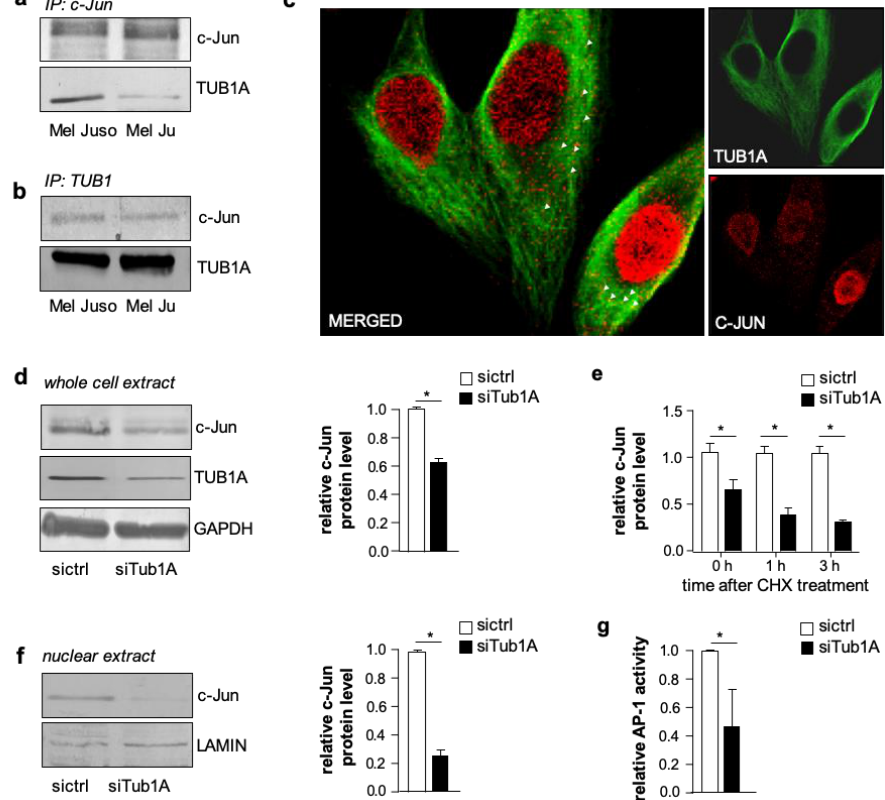
Figure 2. c-Jun protein interacts with TUB1A (Tubulin alpha chain) in melanoma cells and TUB1A a ff ects AP-1 activity and stabilizes c-Jun protein. ( a , b ) Immunoprecipitation (IP) analyses of melanoma cell (Mel Juso, Mel Ju) lysates revealed co-precipitation of TUB1A with an ( a ) anti-c-Jun antibody and vice versa, ( b ) c-Jun with anti-TUB1A antibody. ( c ) Immunofluorescence analyses showed co-localization (white arrows) of c-Jun (red) and TUB1A (green) in the cytoplasm of melanoma cells. ( d ) Western blot analyses and densitometry of c-Jun and TUB1A in whole cell lysates of Mel Juso cells after TUB1A si-RNA (siTub1A) or control si-RNA (sictrl) transfection. GAPDH (Glyceraldehyde-3-Phosphate Dehydrogenase) was used as a loading control. The bar graph depicts the quantification of protein amounts (mean ± s.d.) of three independent experiments. ( e ) Analyses of c-Jun protein expression in TUB1A-suppressed (siTub1A) and control (sictrl) Mel Juso cells after cycloheximide (CHX) treatment showed a faster decline of c-Jun levels in siTub1A compared to control cells. The bar graph (mean ± s.d. of three western blot analyses) depicts c-Jun levels normalized to GAPDH. ( f ) Western blot analyses and densitometry of nuclear extracts of Mel Juso cells showed lower c-Jun protein levels in TUB1A-suppressed (siTub1A) compared to control (sictrl) cells. The bar graph depicts c-Jun levels of three western blot analyses relative to LAMIN (Lamin A / C), which was used as a loading control. ( g ) AP-1 luciferase reporter gene analyses showed reduced AP-1 activity in TUB1A-suppressed (siTub1A) Mel Juso cells compared to control (sictrl) cells. Bars show the means ± s.d. of three independent experiments; measurements were performed in replicates. (*: p <